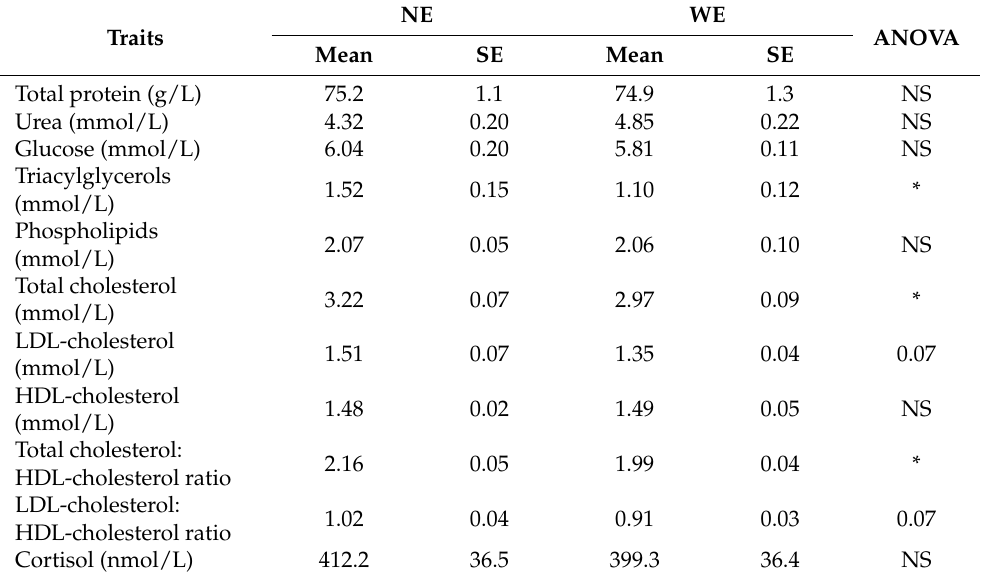
Table 5. Plasma parameters from Alentejano pigs kept on individual pens without exercise area (NE, n = 9) or outdoors with exercise area (WE, n = 9) at slaughter at ~160 kg BW. NE WE Traits